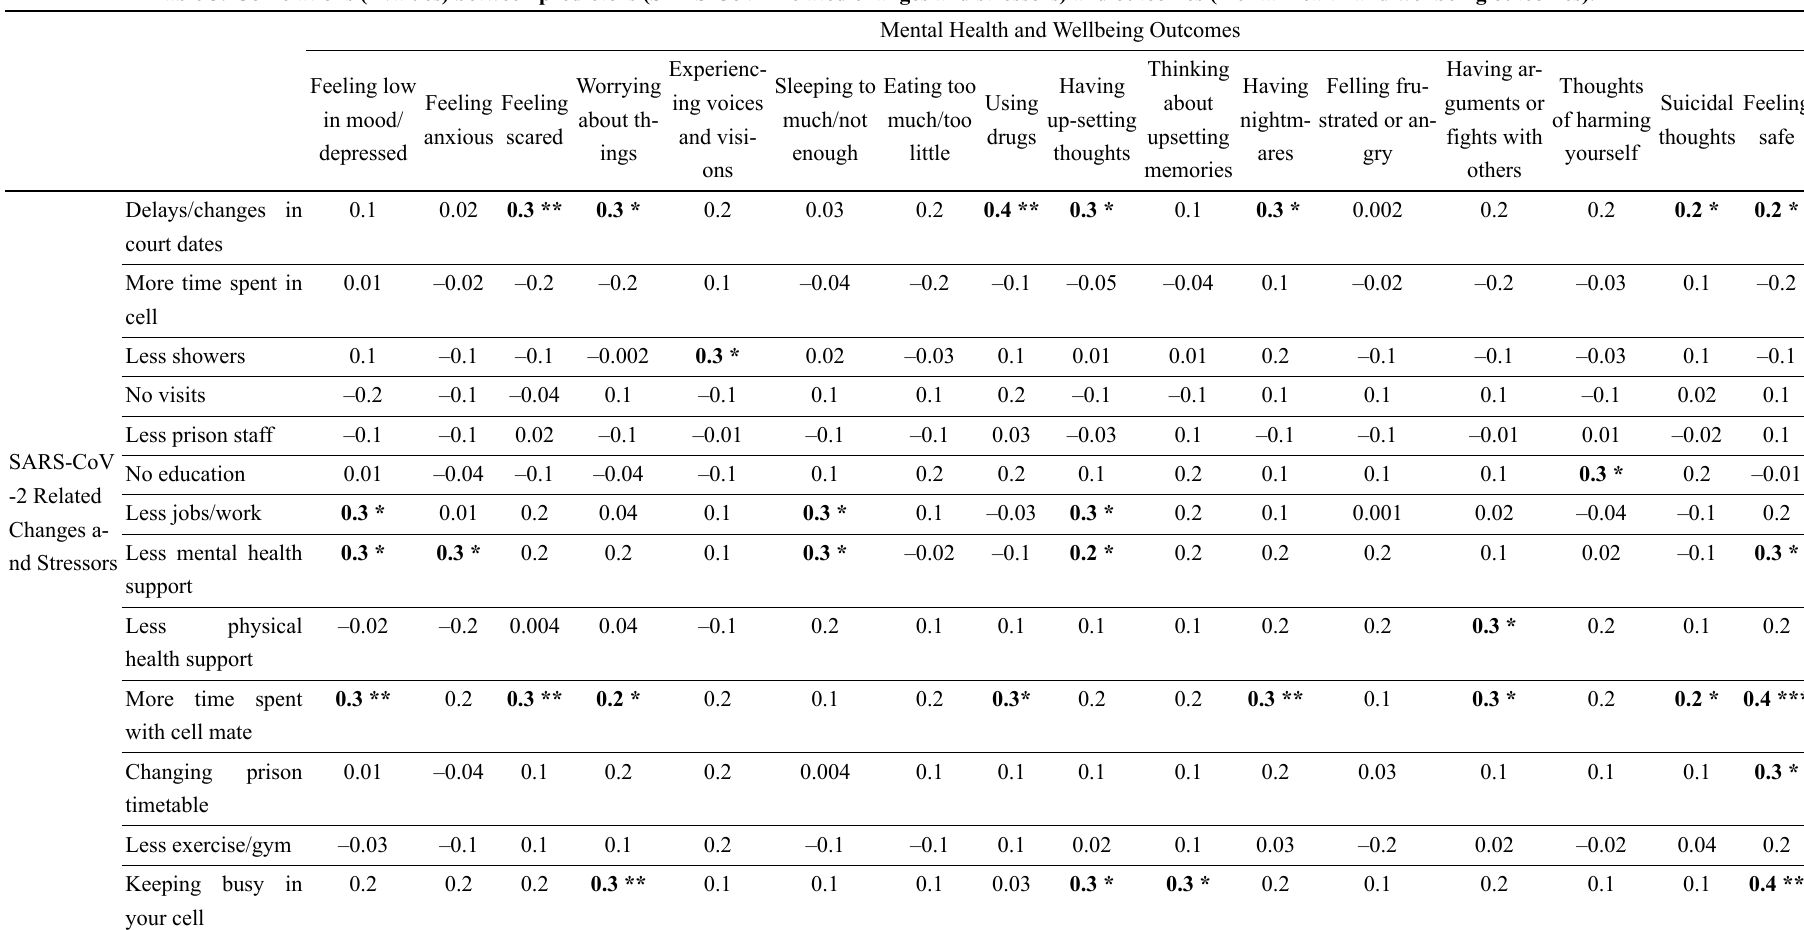
Table 3. Correlations ( r values) between predictors (SARS-CoV-2 related changes and stressors) and outcomes (mental health and wellbeing